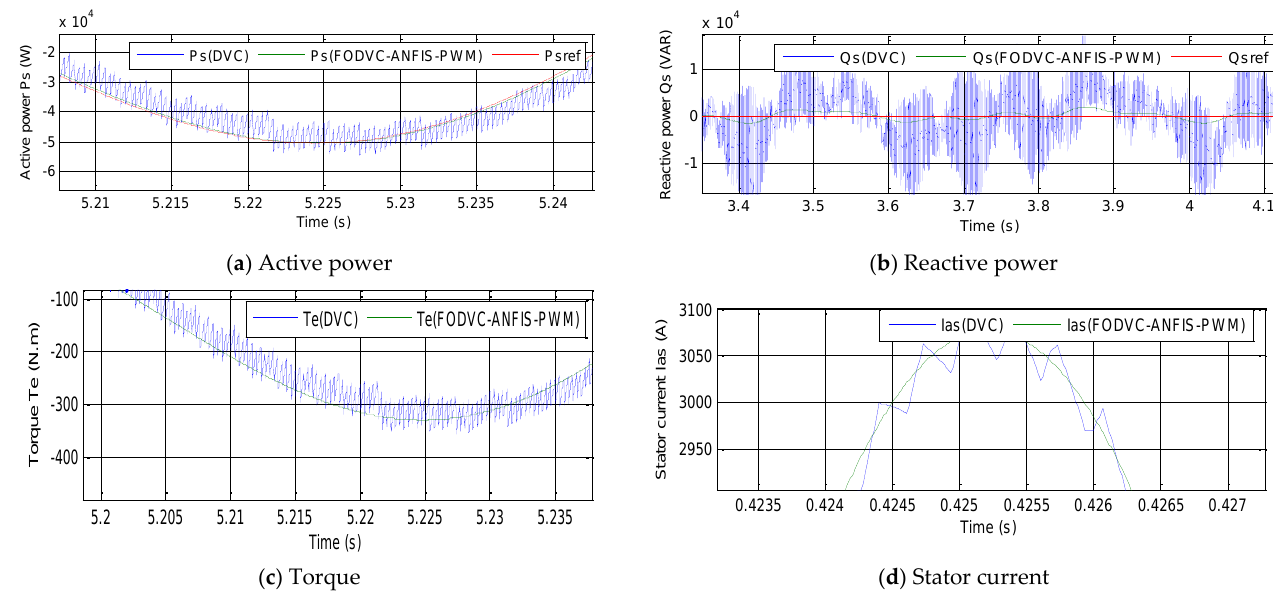
Figure 16. Zoom in the reactive power, torque, active power, and current.